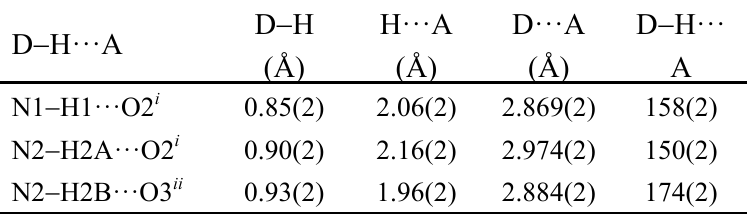
Table 2. Hydrogen-bonding geometry for 2